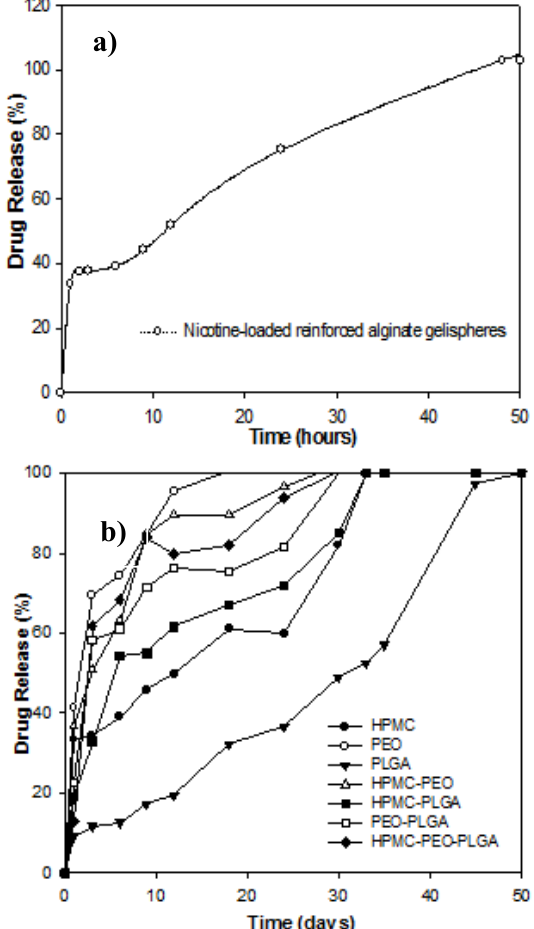
Figure 3. Drug released (%) from: ( a ) nicotine-loaded reinforced alginate gelispheres, and ( b ) nicotine-loaded reinforced alginate gelispheres compressed into polymeric discs following exposure to simulated cerebrospinal fluid (CSF) over a period of 50 hours ( N = 3; SD < 0.53) and 50 days ( N = 3; SD < 0.59%) respectively.